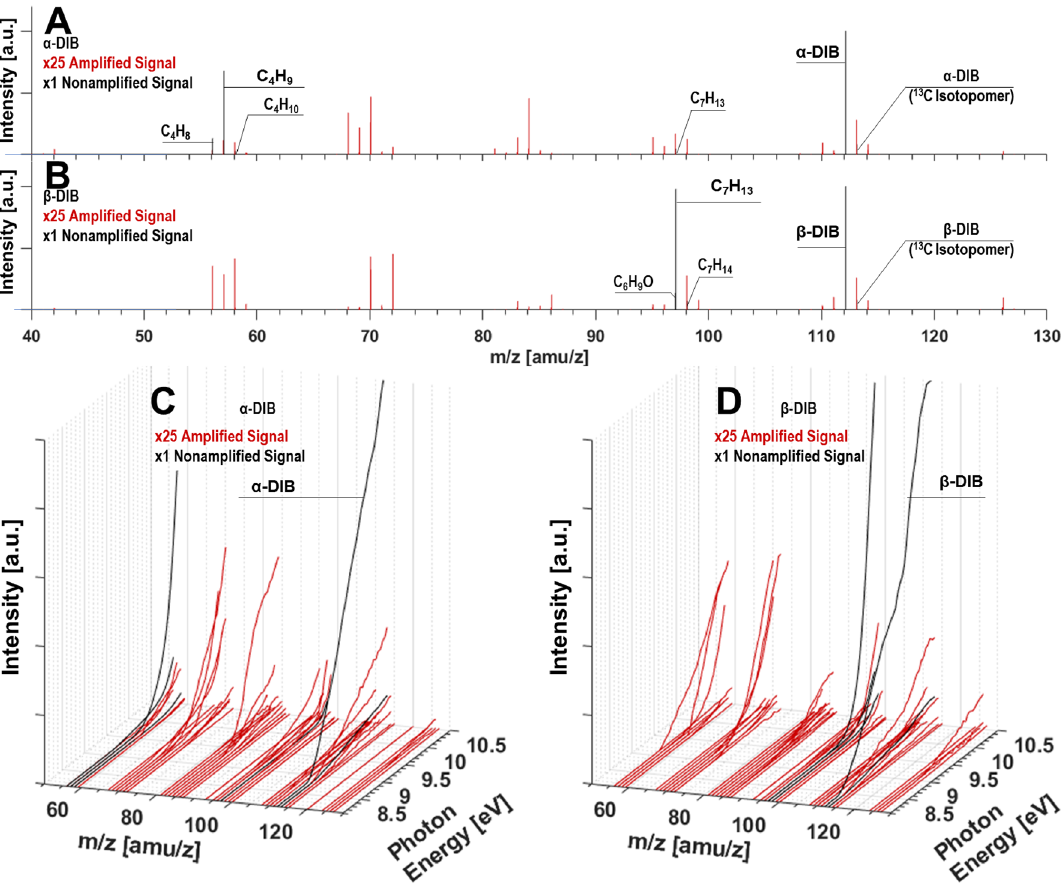
Figure 4. Intensity plots for α- and β-DIB: ( A ) and ( B ) at 10.5 eV photoionization, and ( C ) and ( D ) shown isometrically as a function of photon energy. Signals in red are multiplied by a factor of 25. *See this figure in the supporting info for enhanced